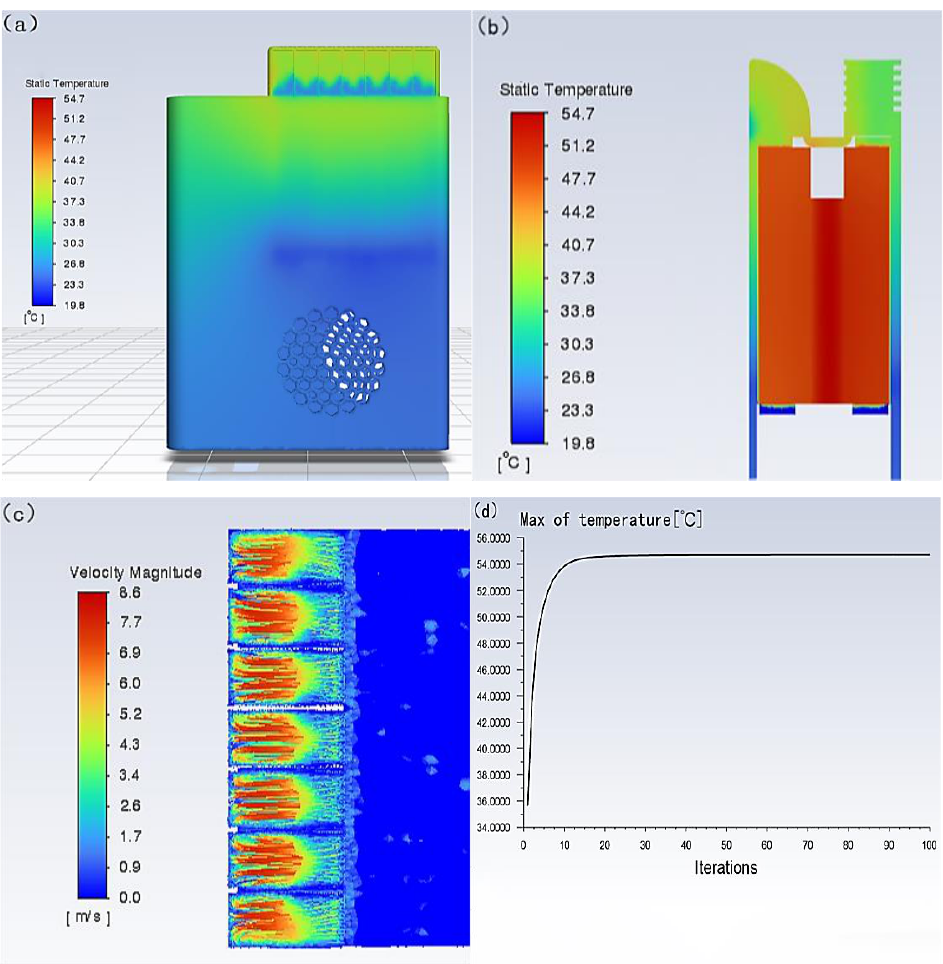
Figure 11. Simulation results of hot air surface. ( a ) Simulated temperature distribution cloud of the hot air surface of the portable refrigeration device. ( b ) Simulated temperature cloud of hot air section of portable refrigeration device. ( c ) Portable refrigeration device heat flow outlet velocity traces. ( d ) Maximum temperature variation curve of portable refrigeration device.